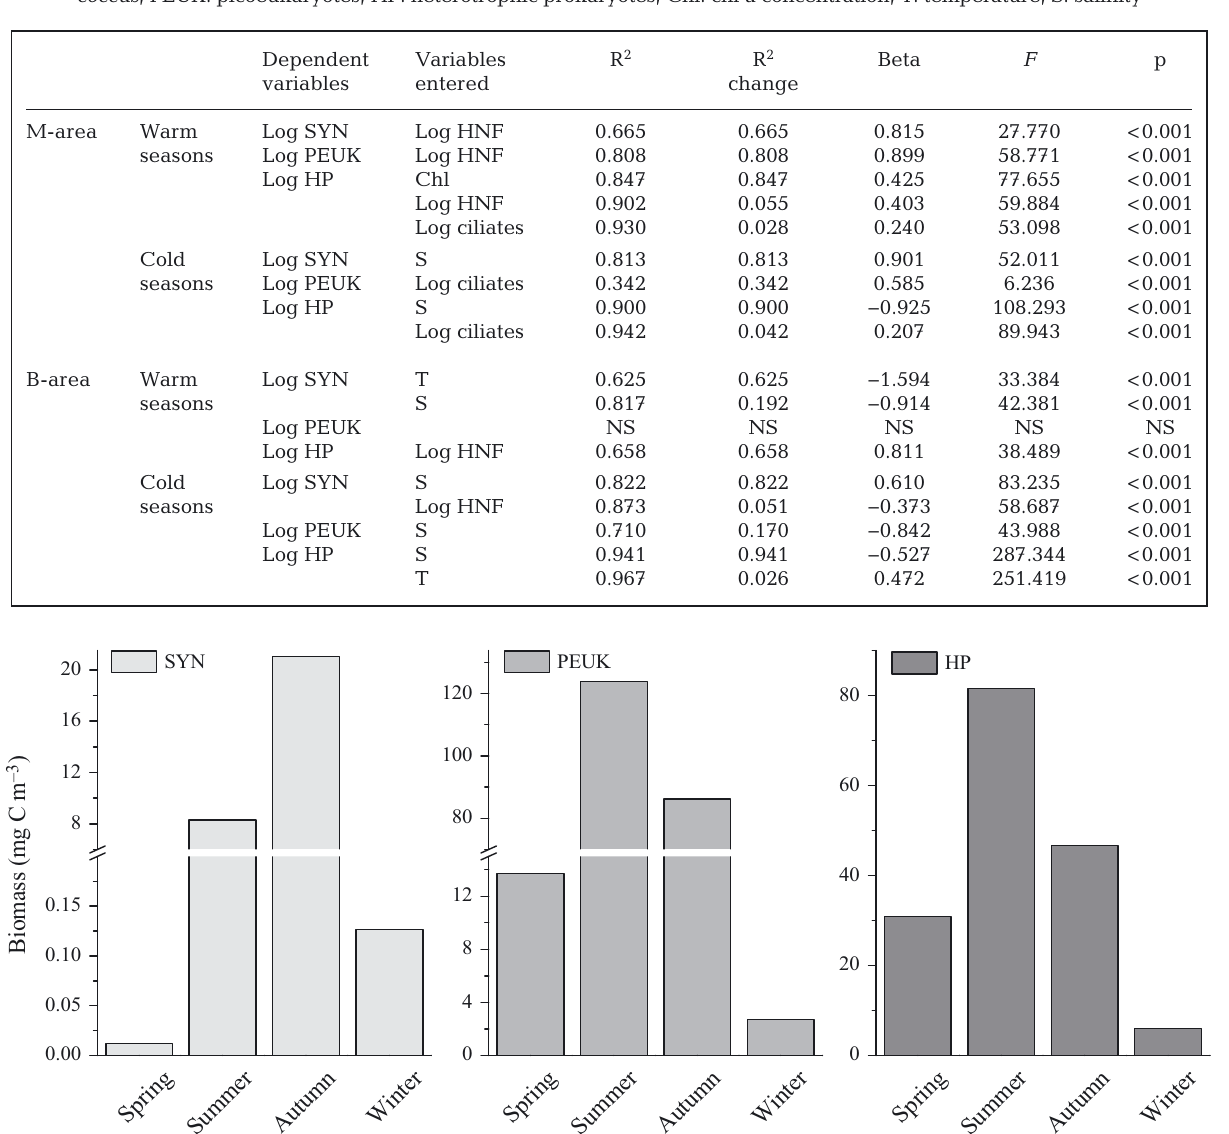
Table 3. Summary of multiple stepwise regression analysis between picoplankton abundances and environmental and bio - logical variables in culture areas of Sanggou Bay and adjacent area (M-area: macroalgae culture, B-area: bivalve culture; see Fig. 1) in warm (summer, autumn) and cold (winter, spring) seasons. Picoplankton, heterotrophic nanoflagellate (HNF) and cil- iate abundances were log transformed prior to analysis. R 2 : correlation coefficient of multiple determination. R 2 change: